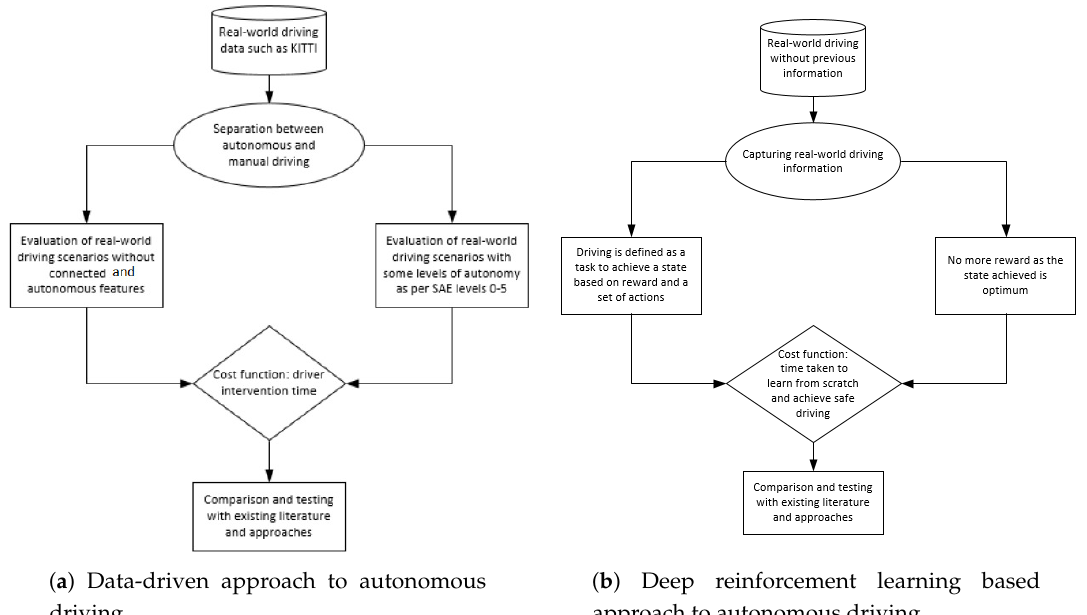
Figure 1. A comparison of data-driven and deep reinforcement learning based approaches to autonomous driving